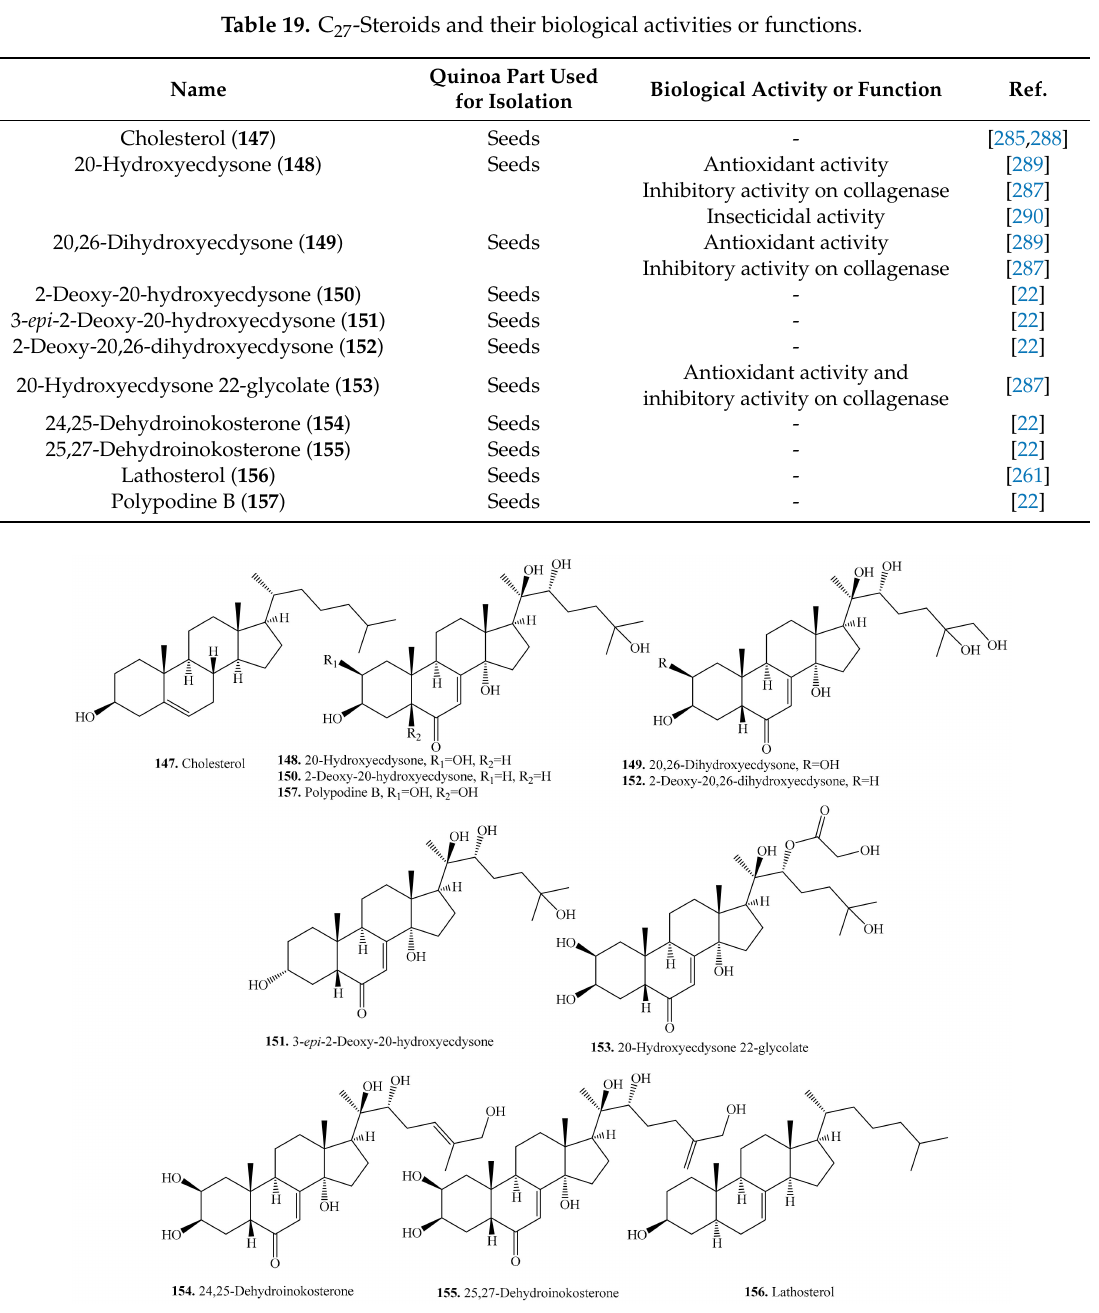
Figure 22. Structures of the C 27 -steroids isolated from